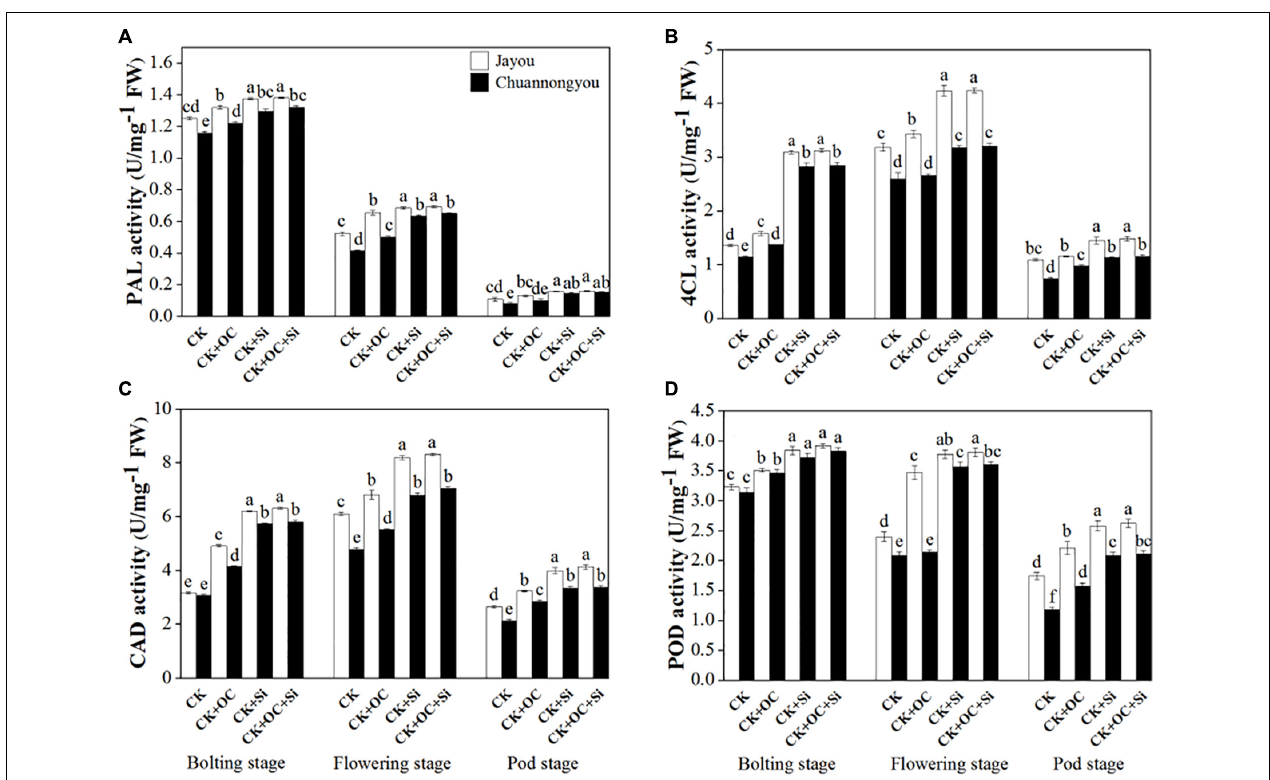
FIGURE 4 | Effect of organic carbon and silicon fertilizers on the enzymes related to lignin biosynthesis in rapeseed stems (A) PAL, phenylalanine ammonia-lyase activity, (B) 4CL, 4-coumarate: CoA ligase activity, (C) CAD, cinnamyl alcohol dehydrogenase activity, and (D) POD, peroxiredoxins activity. Bars represent the means ± SD ( n = 3). Different lower-case letters indicate significant differences among treatments at p ≤ 0.05 (LSD test). The CK, CK + OC, CK + Si, and CK + OC + Si represent the conventional fertilization, conventional + organic carbon fertilization, conventional + silicon fertilization treatment, and conventional + organic carbon + silicon fertilization